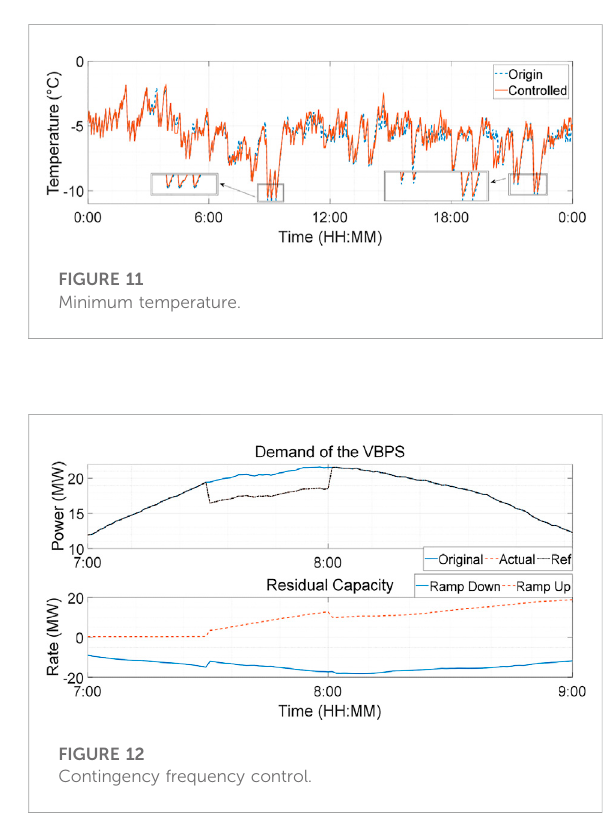
FIGURE 10 Regulation services.